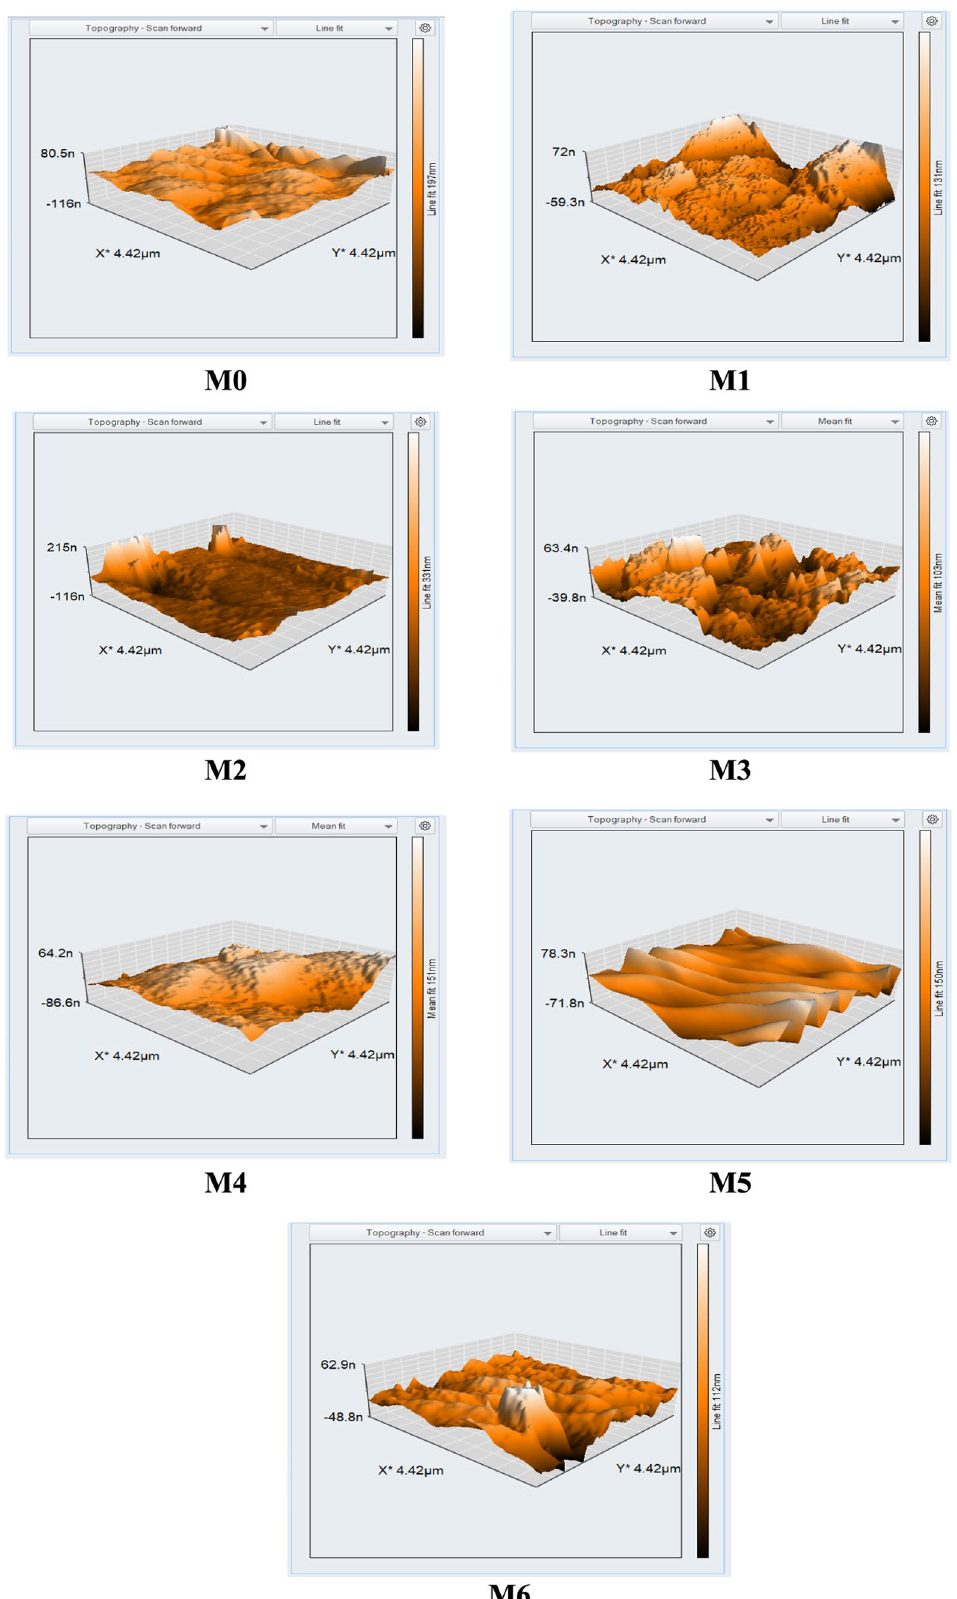
Fig. 5 AFM topographies of the fabricated